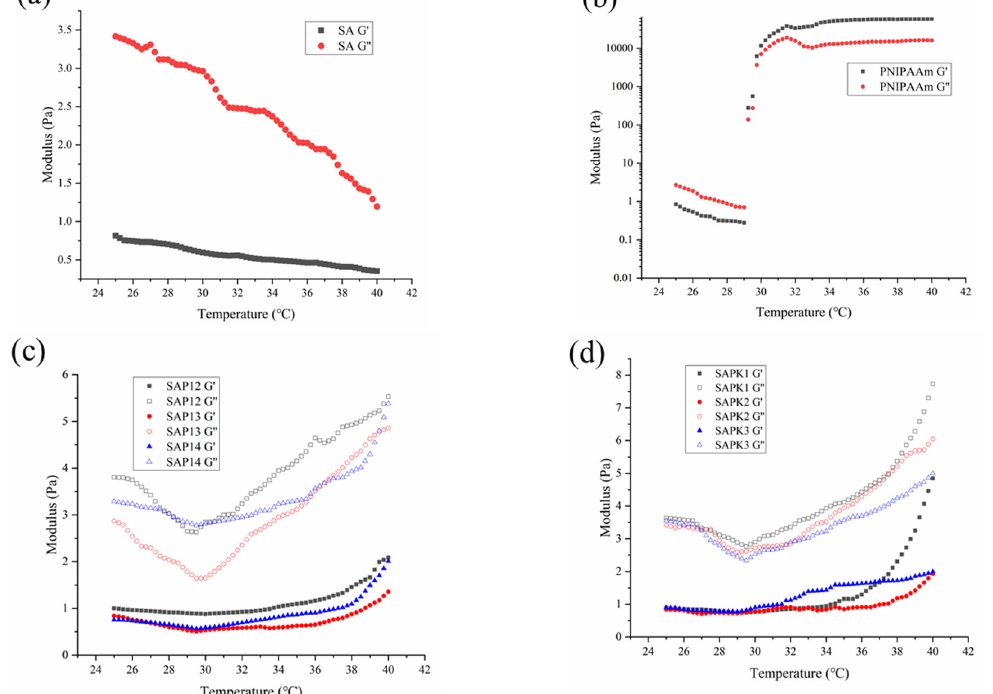
Figure 8. Temperature dependence of storage modulus (G’) and loss modulus (G”) of aqueous samples prior to crosslinking: ( a ) SA, ( b ) PNIPAAm, ( c ) SAP12, SAP13, and SAP14, and ( d ) SAPK1, SAPK2, and SAPK3.